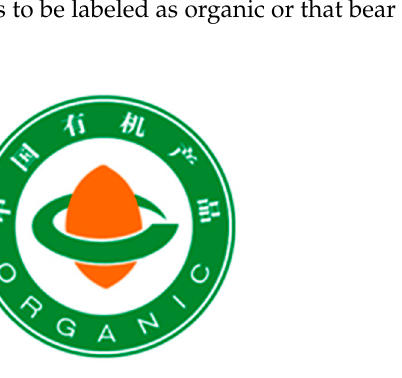
Figure 1. China Organic Product Certification Mark. Source: https://www.organic ‐ bio.com/en/labels.